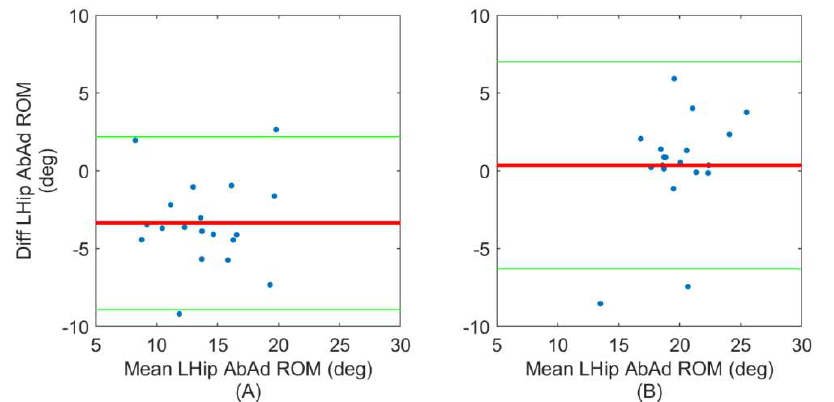
Figure 6. Bland–Altman plots of the left hip mean abduction/adduction (AbAd) range of motion during ( A ) normal walking and ( B ) lateral left walking. Comparison is between IMU and IK methods (IMU-IK). Plot represents matched estimates for all 19 subjects evaluated in these movements. Bias (thick, red) and 95% limits of agreement (thin, green) are also displayed. Limits of agreement calculated as Bias ± 1.96 SD where Bias is the mean and SD is the standard deviation of the differences in the estimates.